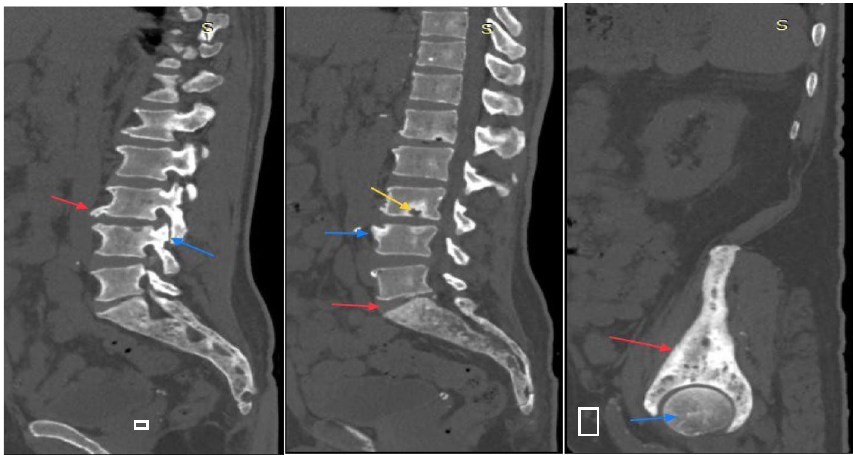
Fig. 1 Sagittal plane bone window MDCT shows spondylotic changes presented by vertebral osteophyte and facet joint sclerosis with narrowing ( A red and blue arrows), Schmorl’s nodes ( B yellow arrow) and narrow L5-S1disc space ( B red arrow), and typical changes of PDB in left pelvic bone with normal left femoral head ( C red & blue arrows)